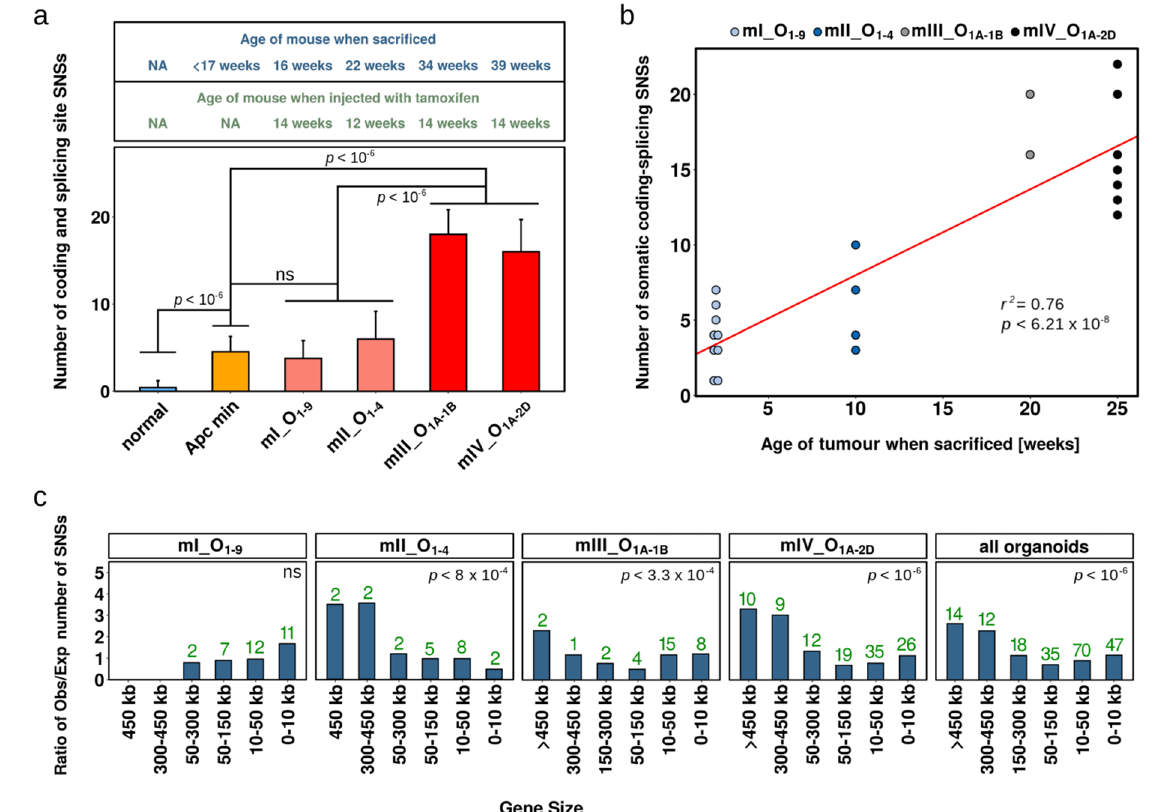
Figure 3. Relation of number of SNSs per organoid to age of the tumour and distribution of SNSs in the genome according to gene size. ( a ) Average number of somatic SNSs in normal and tumour organoids of Apc min/+ mice and in tumour organoids of AKP mice. Organoids originating from mice I and II displayed a similar mutational burden as organoids from Apc min/+ mice, whereas organoids from mice III and IV had a higher mutational burden. Data are presented as mean + 1 SD and compared using the Student’s t test. p values were corrected for multiple testing using the Benjamini–Hochberg method. ( b ) Linear regression correlation of the number of somatic coding and splice site SNSs to the time over which the tumours developed, calculated from the dates at which the mice were injected with tamoxifen and sacrificed. The p value and the value of the coefficient of determination R 2 are indicated. ( c ) Distribution of SNSs according to gene size. The graphs show the ratios of observed (Obs) versus expected (Exp) number of SNSs for each gene category. The observed number of SNSs is indicated by the green letters. With the exception of mouse I, the somatic SNSs were significantly more prevalent in the large genes. Significance was evaluated by calculating the expected distribution of SNSs in the genes 0–150 kb in size versus the genes >150 kb. A random number generator was used to assign each SNS to one or the other group of genes, according to the total length of the coding sequences of each group of genes. Once all SNSs had been assigned, the number of SNSs mapping to the large genes was compared to the observed number. This process was repeated one million times, and the p value corresponded to the number of times that more randomly assigned SNSs mapped within large genes than what was